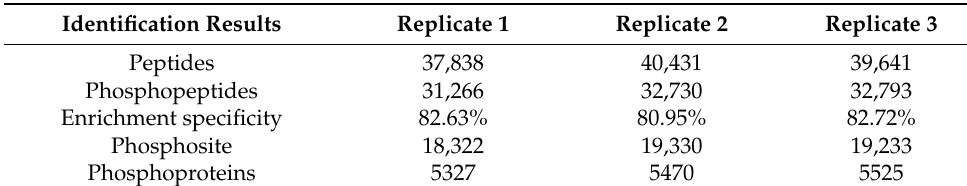
Table 2. Identification results of the phosphoproteome of 293T cells using TiO 2 enrichment with lactic acid and the TEA-based HpH-RP fractionation.